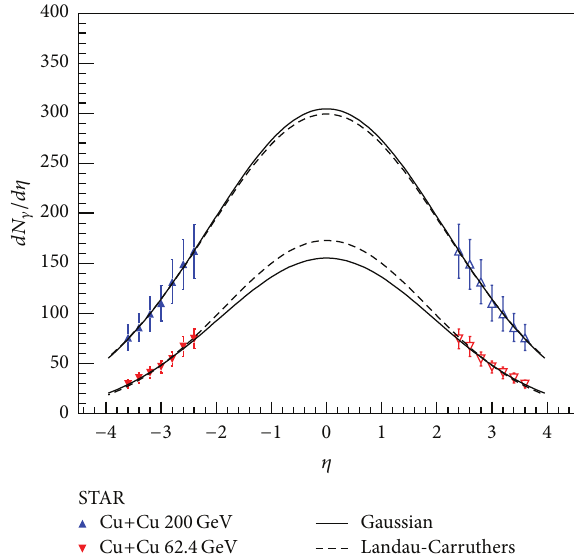
Figure 26: Photon multiplicity distributions of Au+Au collision system as a function pseudorapidity for the most central events for different collision energies.